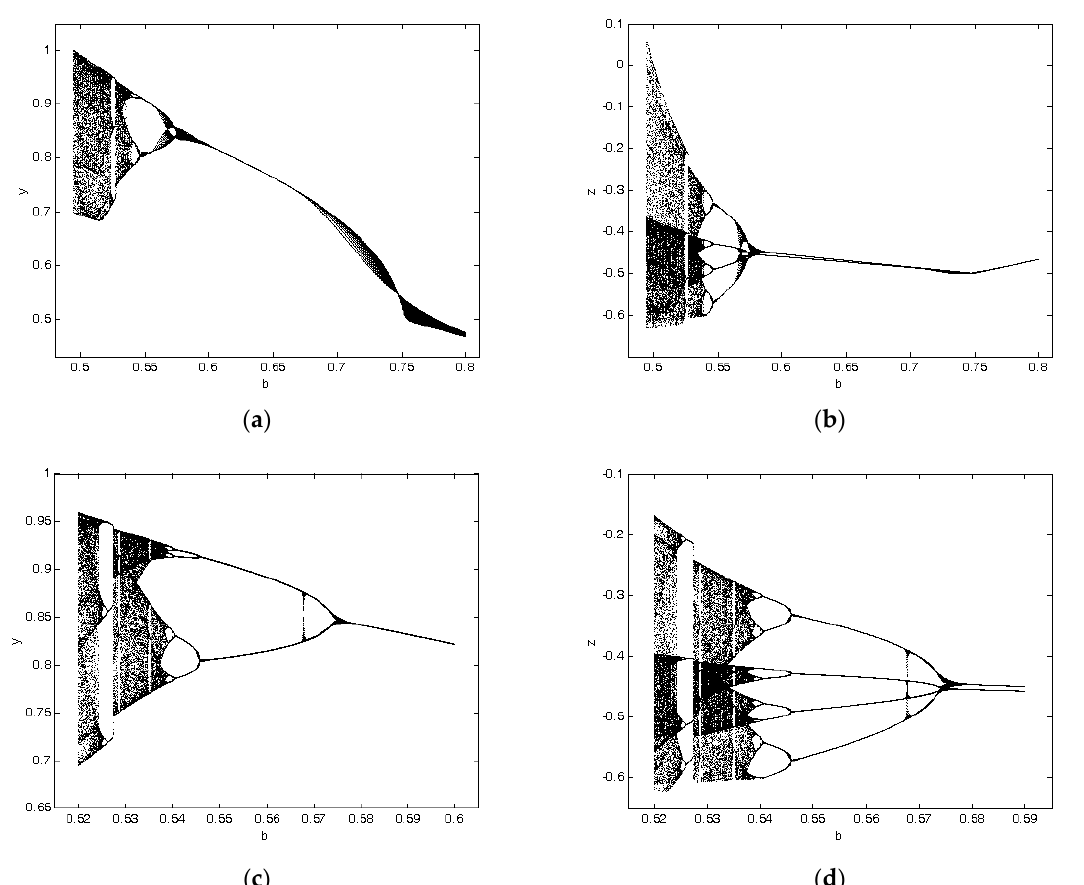
( ) ( ) ty versus b ; and ( b , d ) tz versus b , generated by computer solution of the Figure 2. Bifurcation diagrams: ( a , c ) Figure 2. Bifurcation diagrams: ( a , c ) y ( t ) versus b ; and ( b , d ) z ( t ) versus b , generated by computer solution of the system [ ] ( ) ( ) ( ) 77.0,495.0 ∈ b in ( a , b ); and .1.0000 === zyx Note that system (1) at 51.1 −= a . The initial conditions are (1) at a = − 1.51. The initial conditions are x ( 0 ) = y ( 0 ) = z ( 0 ) = 0.1. Note that b ∈ [ 0.495,0.77 ] in ( a , b ); and b ∈ [ 0.52,0.6 ] [ ] 6.0,52.0 ∈ b in ( c , d ). in ( c , d